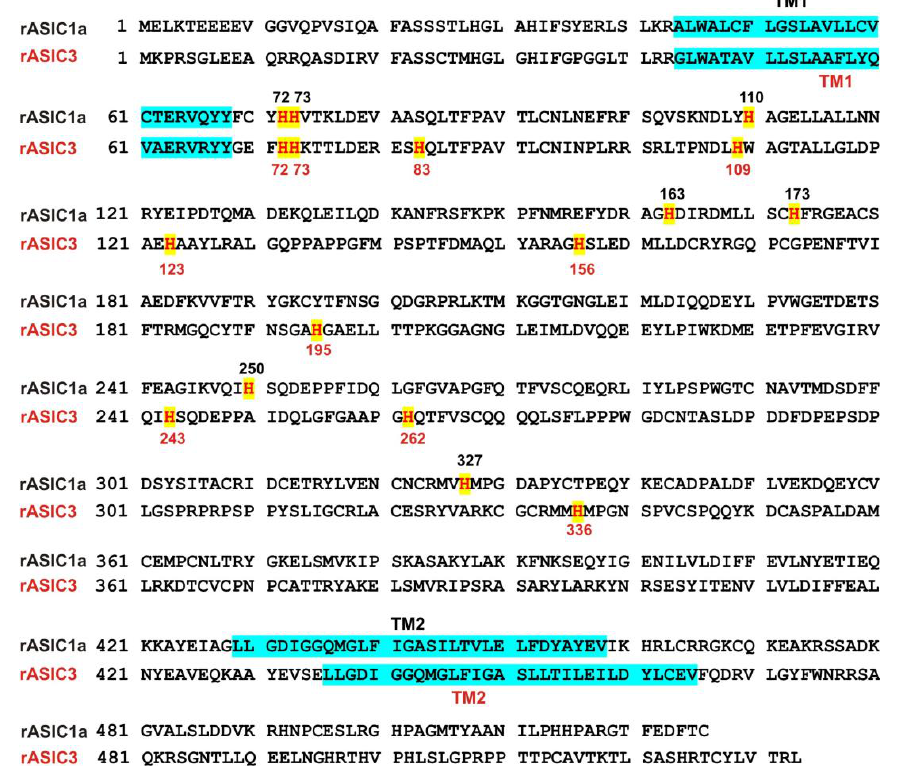
Figure 7. Sequence alignment of rat ASIC1a and rat ASIC3. Sequence alignment of rat ASIC1a (rASIC1a, GenBank ID: 2039366) and rat ASIC3 (rASIC3, GenBank ID: 2352949). Histidine residues in the extracellular domain of rASIC1a and rASIC3 are marked with a yellow color; 7 histidine residues are found in the extracellular domain of rASIC1a and 10 histidine residues are found in the extracellular domain of rASIC3. Transmembrane domain 1 (TM1) and transmembrane domain 2 (TM2) are marked with a dark blue color.